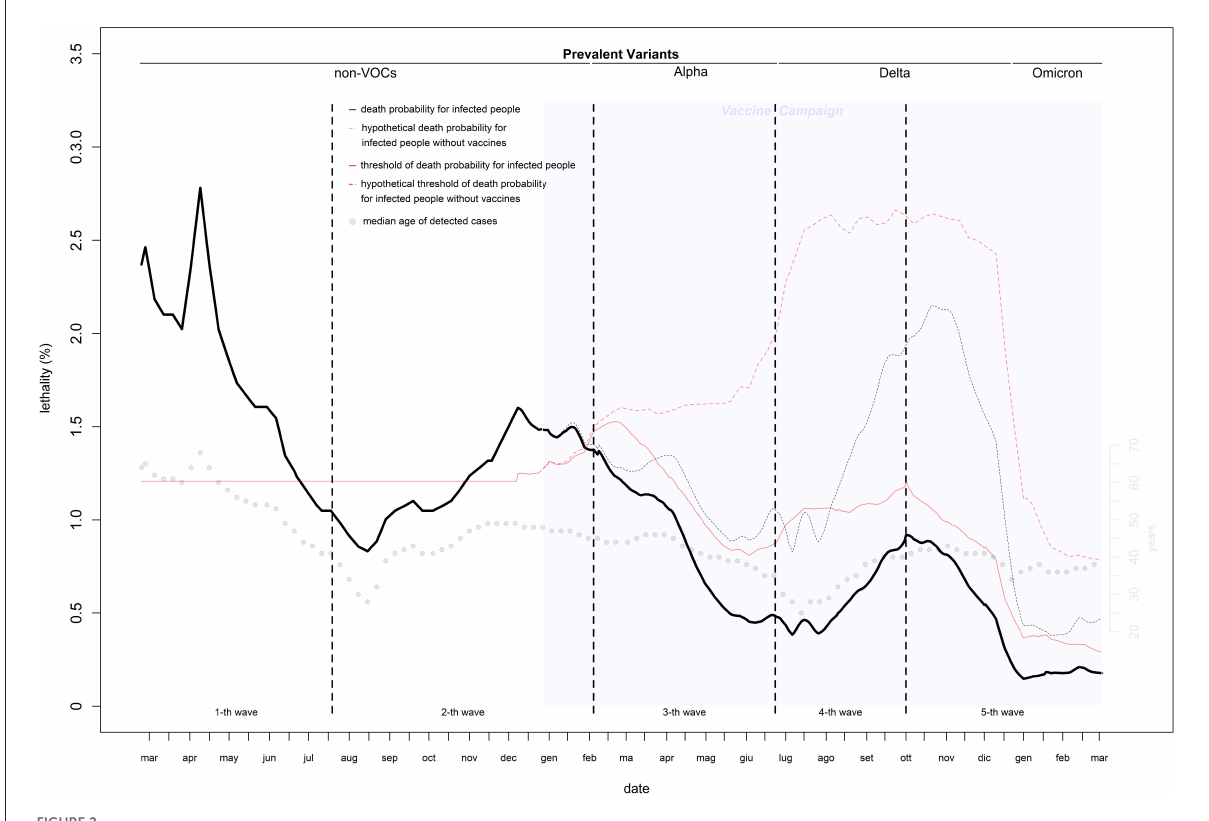
FIGURE2 Daily lethality of COVID-19 in Italy (February